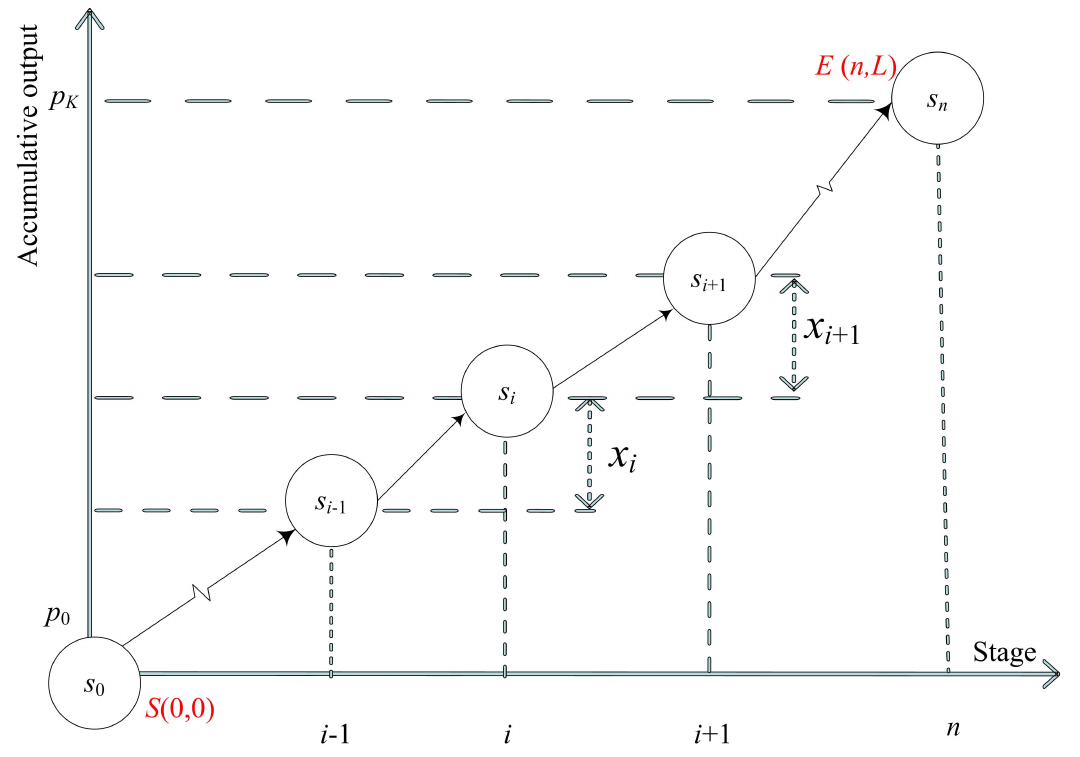
Figure 2. A solution to the discretized OLD problem can be viewed as path from the origin S (0 , 0) to the destination E ( n, L )